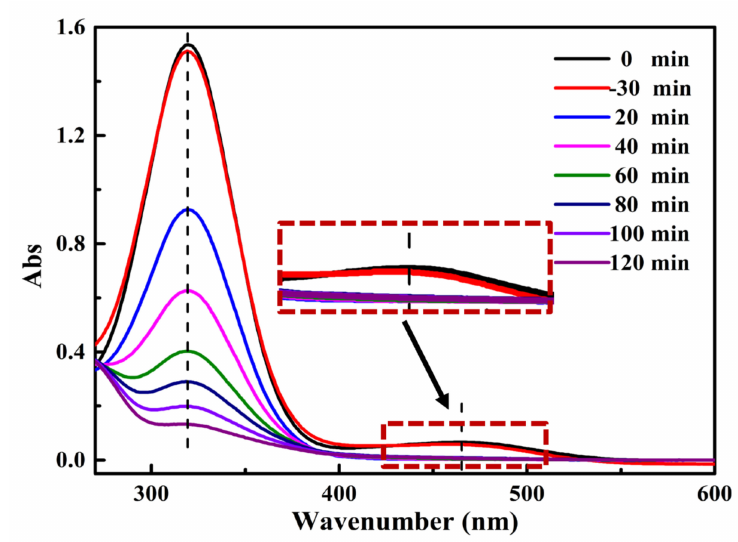
Figure 8. Photocatalytic degradation of mixed